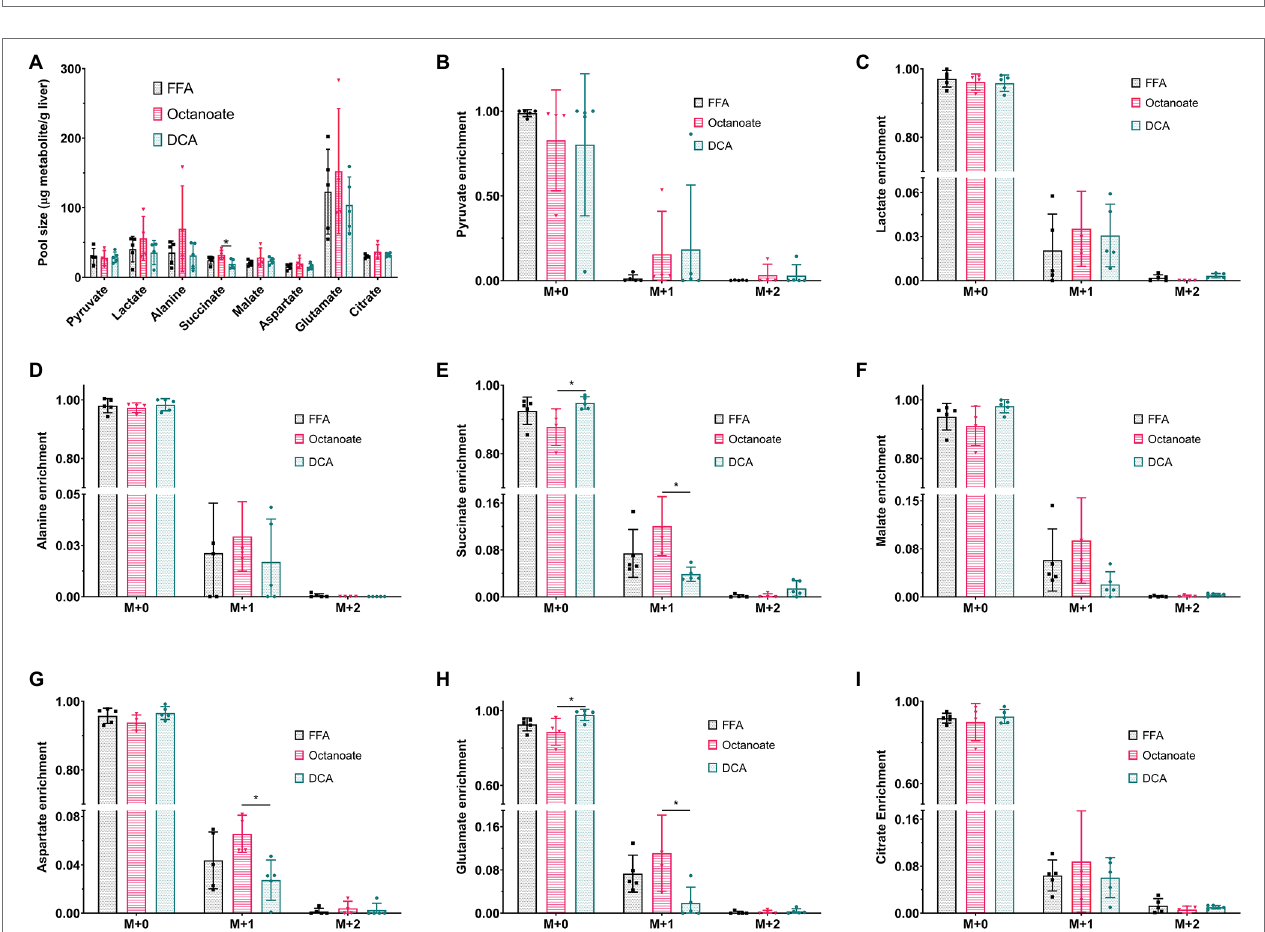
FIGURE 5 | (A) Pool sizes of metabolites extracted from the liver estimated using GC-MS. (B – I) 13 C enrichment of all metabolites shown in (A) . M + 0, M + 1, M + 2, and M + 3 represent individual mass isotopologues. * Indicates statistical significance ( p < 0.05; see section Materials and